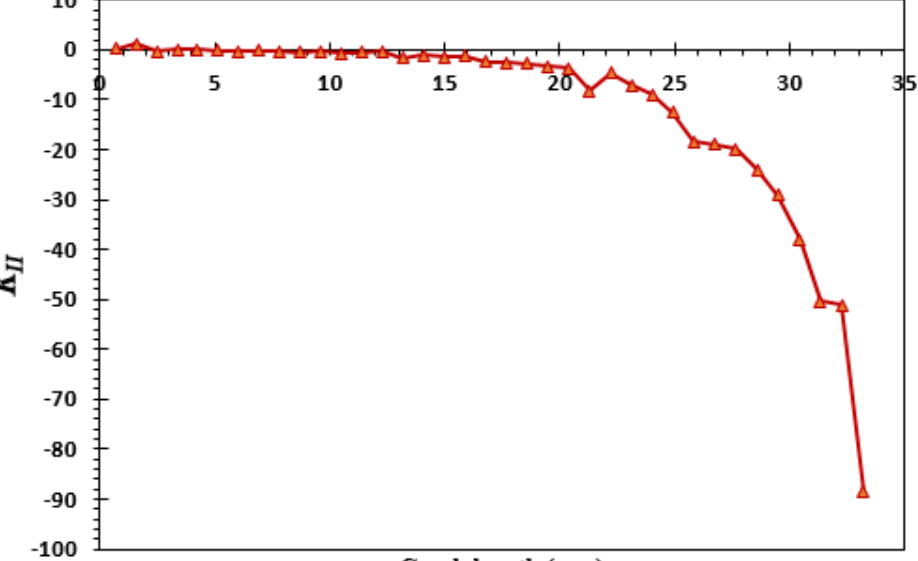
Figure 16. Predicted values of the second mode of stress intensity factors.